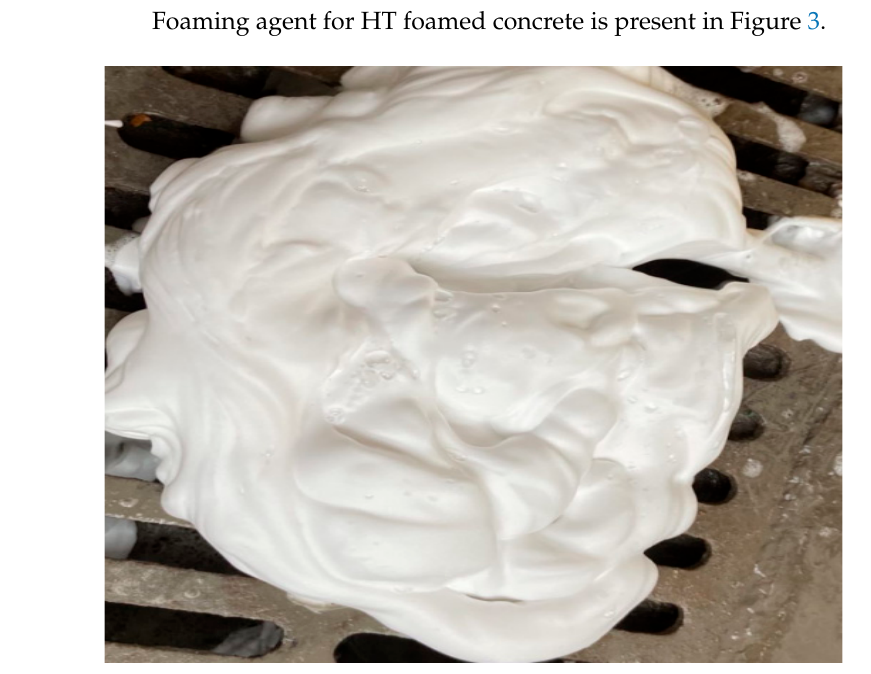
Table 1. Cement physical performance indicators.